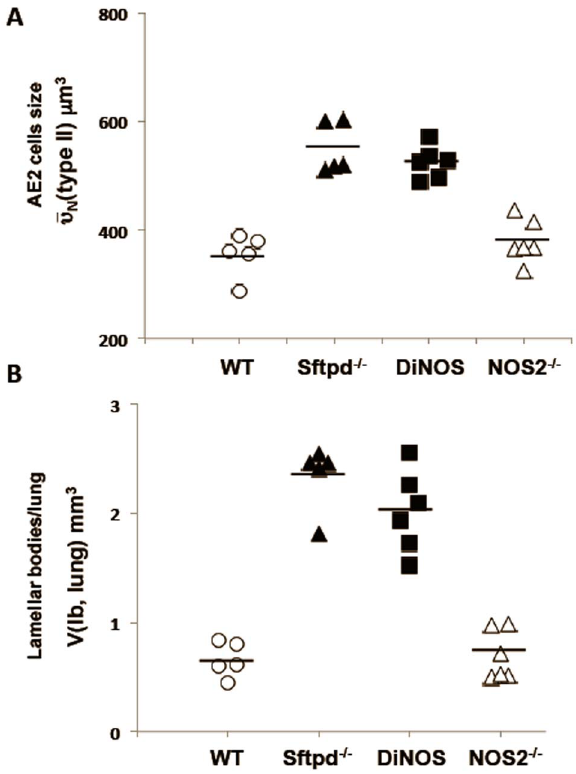
Figure 4. NOS2 ablation does not correct AE2 cell size and surfactant per lung in the absence of SP-D. Hypertrophy of AE2 cells ( (cid:2) nn N (typeII)) is present in Sftpd 2 / 2 and DiNOS to a similar extent ( A ). The increased volume of lamellar bodies per lung V(lb,lung) ( B ) is unaffected by the additional ablation of the NOS2-gene in Sftpd deficient mice. Data shown are mean and individual data, n=5–6 animals per genotype. Statistically significant differences between groups are shown in Table 3.